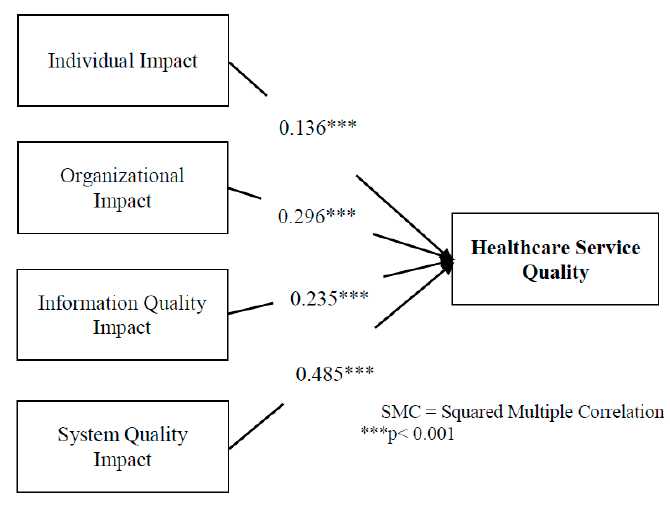
Figure 2. Structural model results.